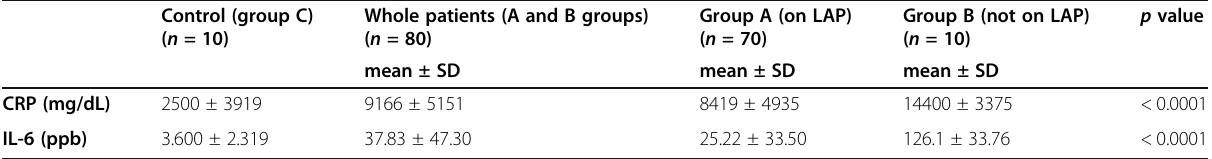
Table 3 Comparison between interleukin-6 and C-reactive protein between control subjects and subgroups Control (group C) Whole patients (A and B groups) ( n = 10) ( n = 80)